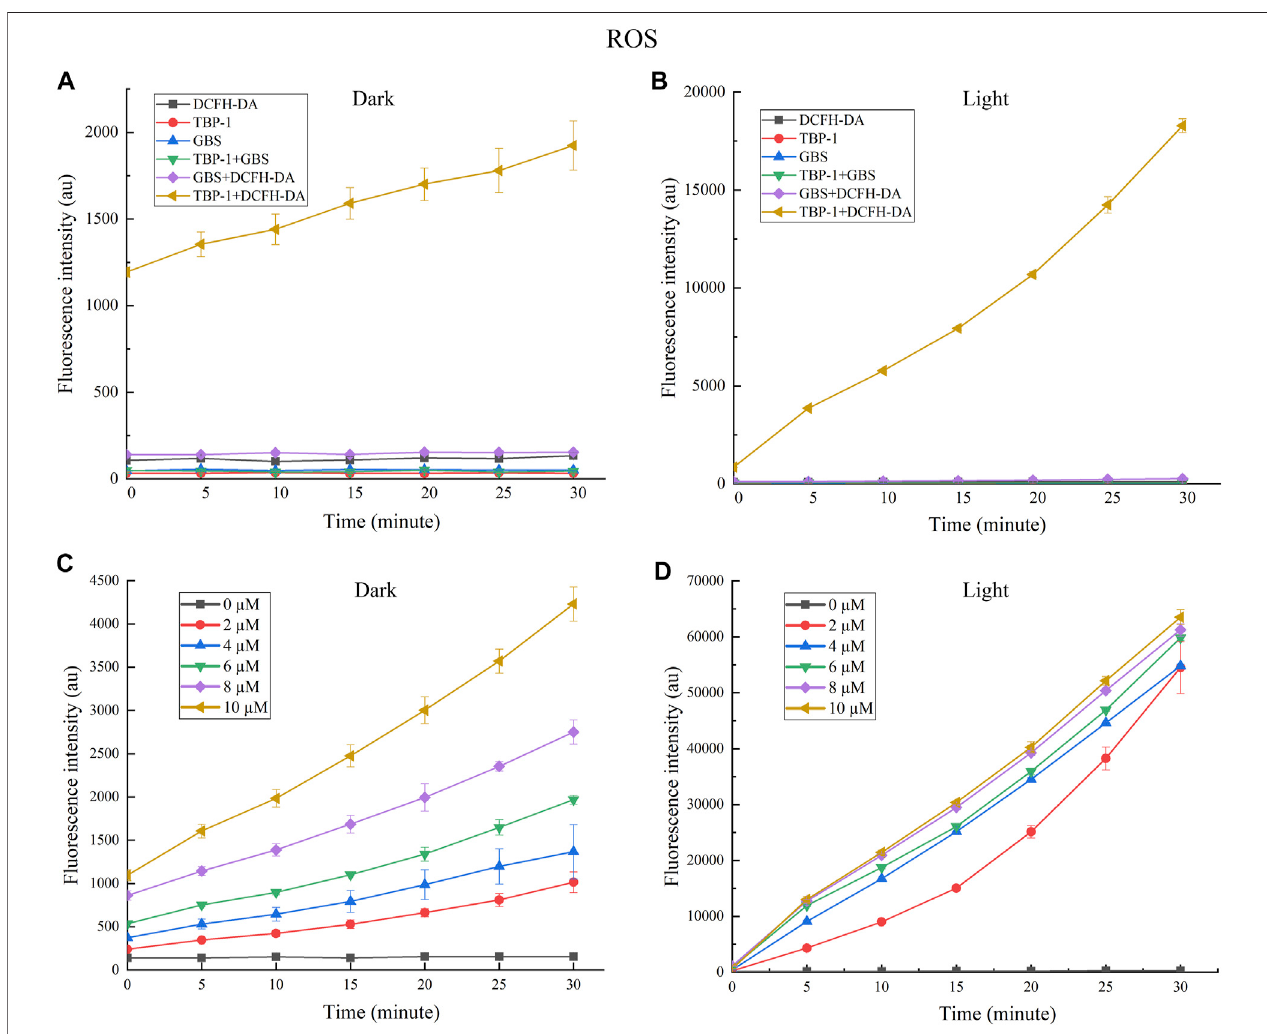
FIGURE2 |(A) Fluorescence intensity at 525 nm generation byTBP-1 (10 µM) and GBS inthe dark vs. theirradiation time with or without DCFH-DA (100 µM). (B) The fl uorescence intensity at 525 nm generation by TBP-1 (10 µM) and GBS under light (4.2 mW cm − 2 ) vs. the irradiation time with or without DCFH-DA (100 µM). (C) The ROS fl uorescence intensity of GBS treated with TBP-1 (0, 2, 4, 6, 8, and 10 µM) in the dark with varying treatment time. (D) The ROS fl uorescence intensity of GBS added with TBP-1 (0, 2, 4, 6, 8, and 10 µM) exposed to light (4.2 mW cm − 2 ) with varying treatment time.